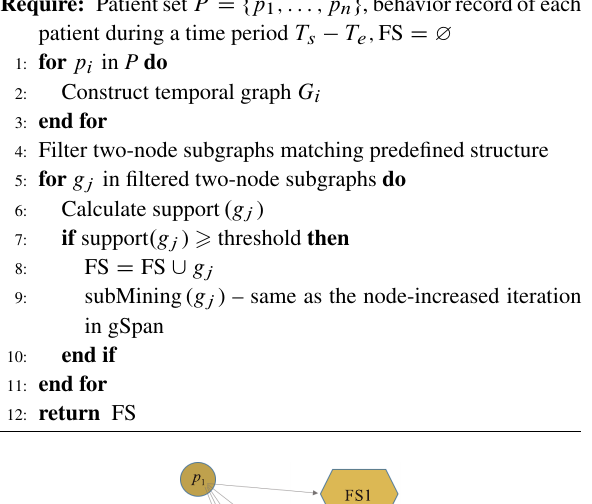
Algorithm 1 Constrained frequent disease-process subgraph mining